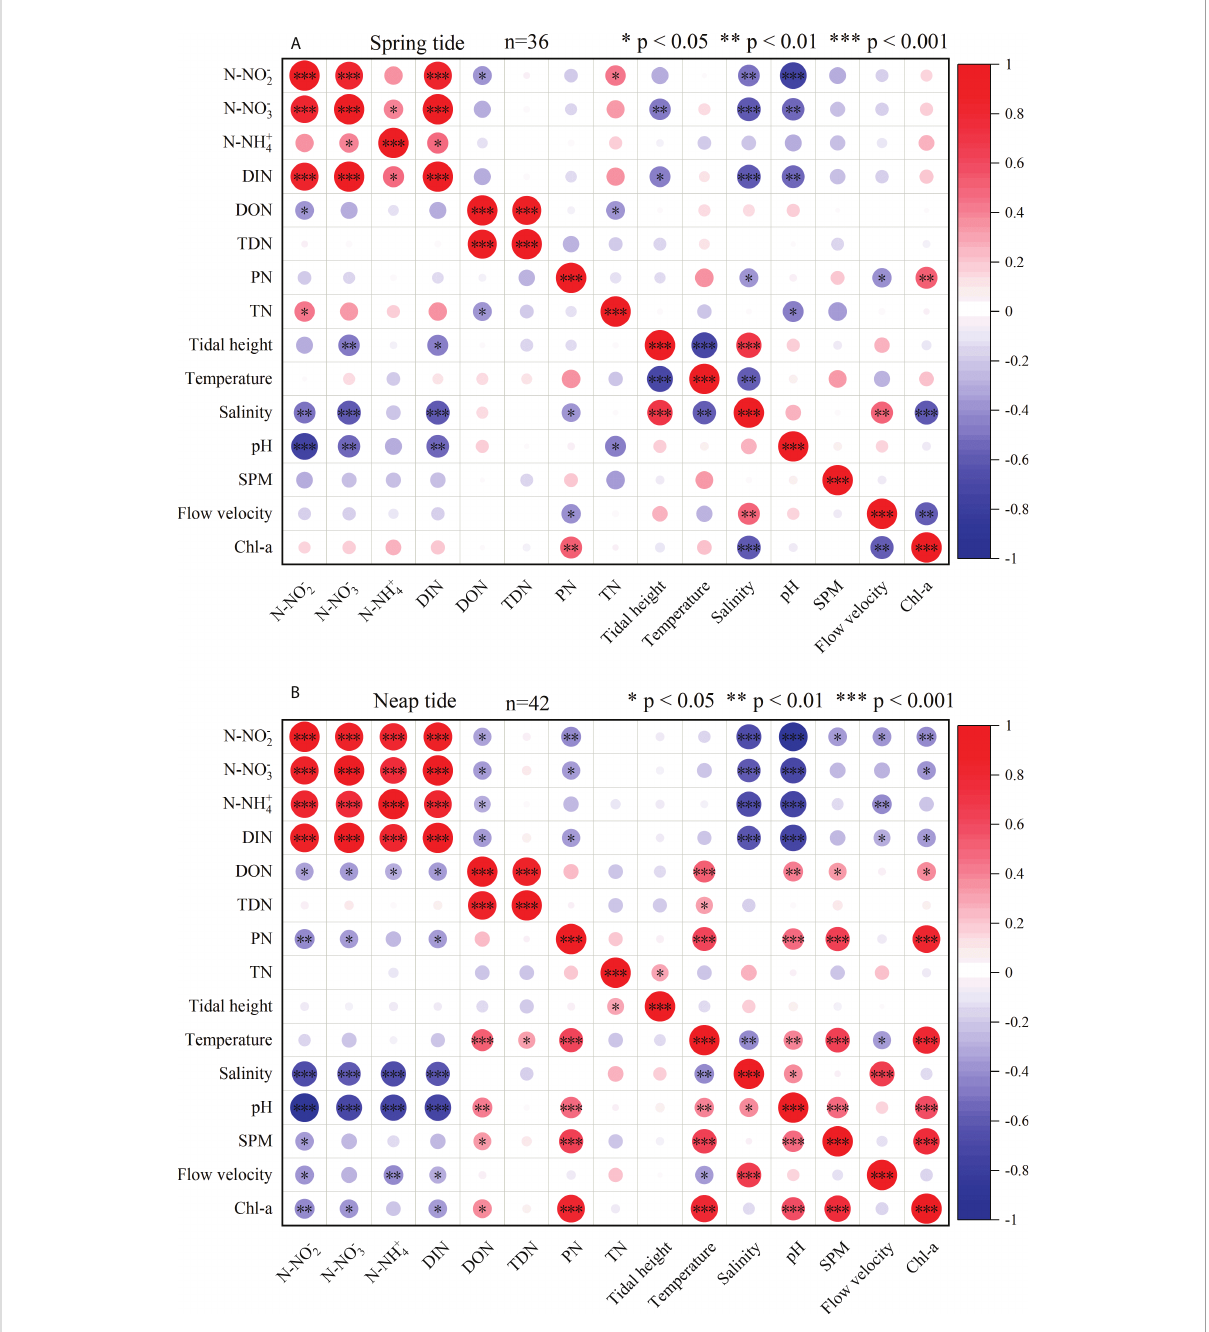
FIGURE 4 Correlation analysis of nitrogen species with environmental factors during spring tide (A) and neap tide (B) in